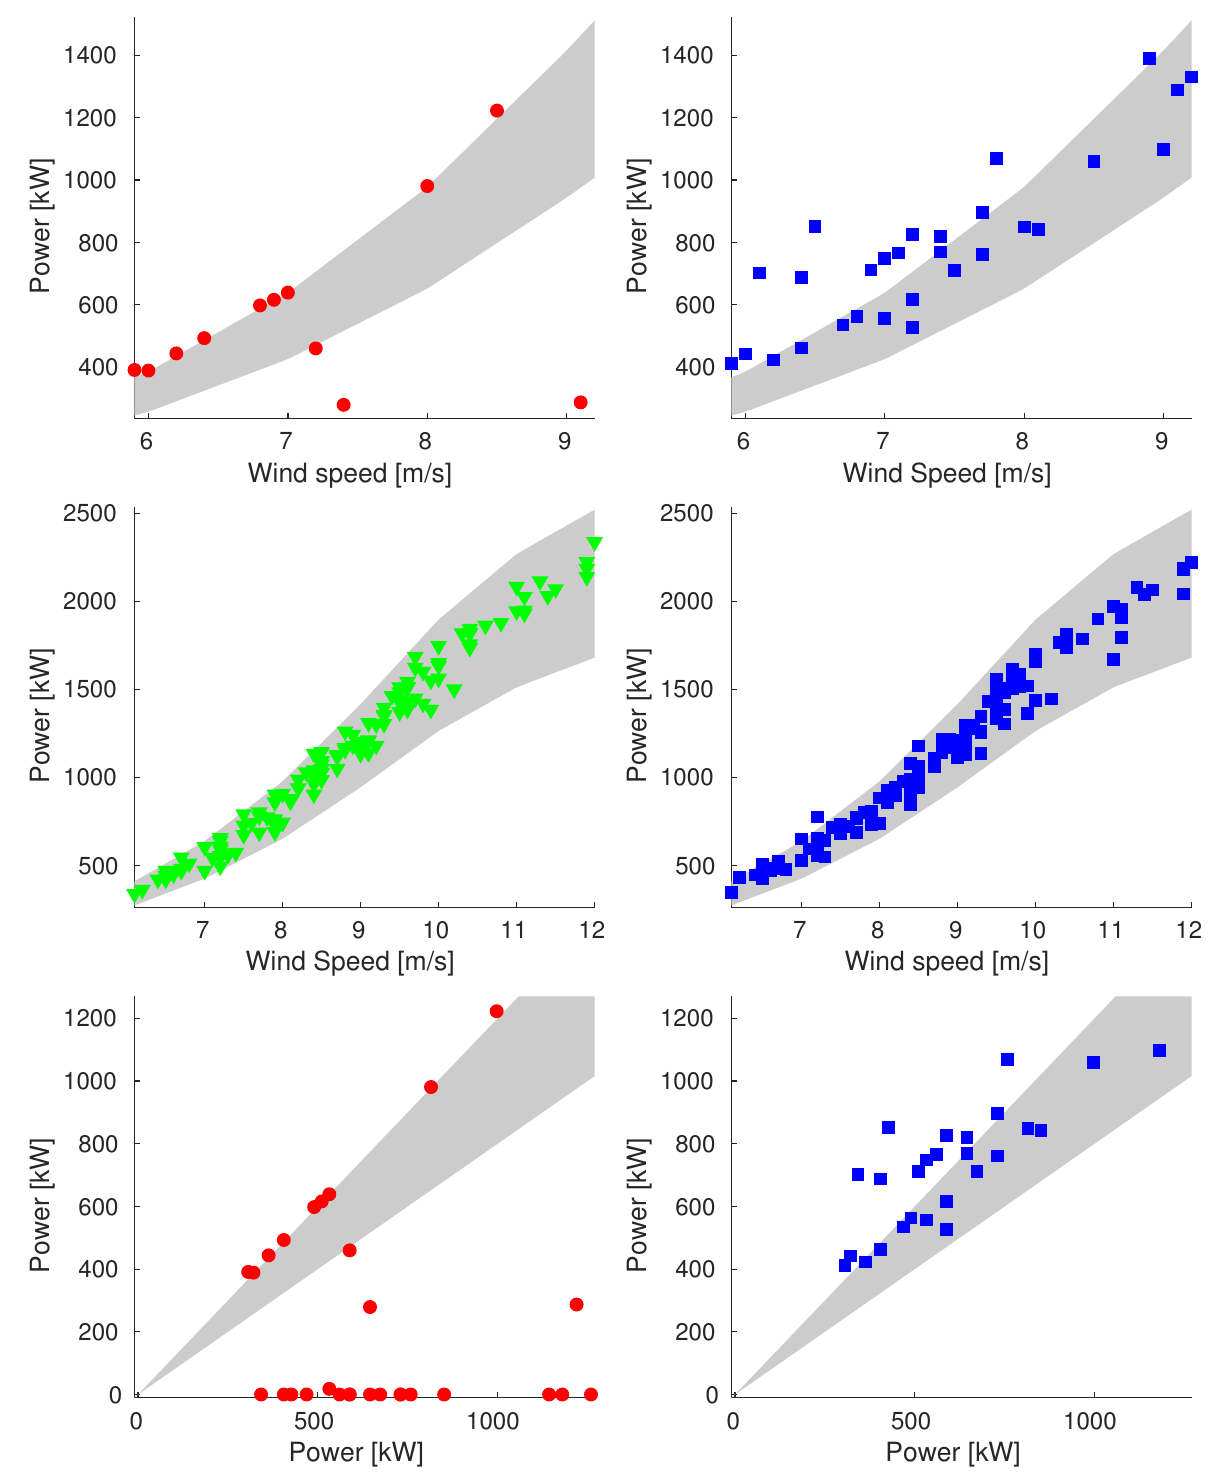
Figure A12. Plot of reconstructions for data points of 11 December ( Sample_100 ). We compare original data (on the left ) and reconstructed values (on the right ). We show plots of power vs.wind speed of rejected and validation data ( up and middle respectively) and plot of power vs.ideal power of rejected data ( bottom